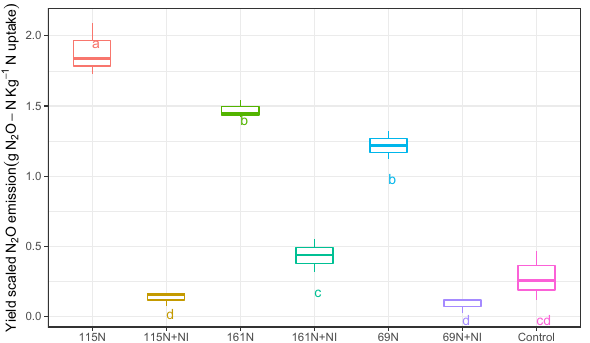
Figure 5. Yield-scaled N 2 O emission of maize at the different levels of N application and with or without NI during the maize growth season in 2018. Means with the same letters are not significantly different according to the least significant difference (LSD) at p < 0.01, n = 3.